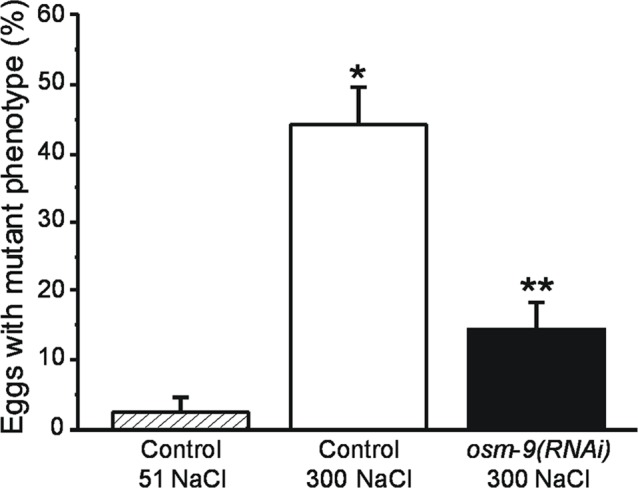
Effect of RNAi induced loss of osm-9 function on let-60(ga89) induced egg hatching defects and larval arrest.let-60(ga89) encodes a ts mutant of ras GTPase. The mutant phenotype can be induced at permissive temperatures (16°C) by exposing worms to 300 mM NaCl [14,16]). let-60(ga89) mutants were crossed with uIs60[Punc-119::yfp + Punc-119::sid-1] worms to increase the sensitivity of neurons to RNAi (46). let-60(ga89);uIs60[Punc-119::yfp + Punc-119::sid-1] worms were fed bacteria expressing scrambled (control) or osm-9 dsRNA and maintained at 16°C on agar plates containing either 51 or 300 mM NaCl. Values are means ± S.E. (n = 3–5 experiments with 100–300 eggs). *P<0.006 compared to control worms exposed to 51 mM NaCl. **P<0.005 compared to control worms exposed to 300 mM NaCl.